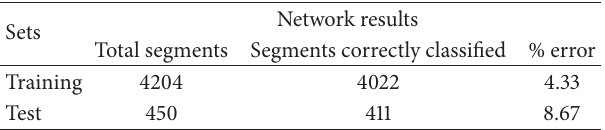
Table 2: Classification model using amino acid adjacency matrix. Sets